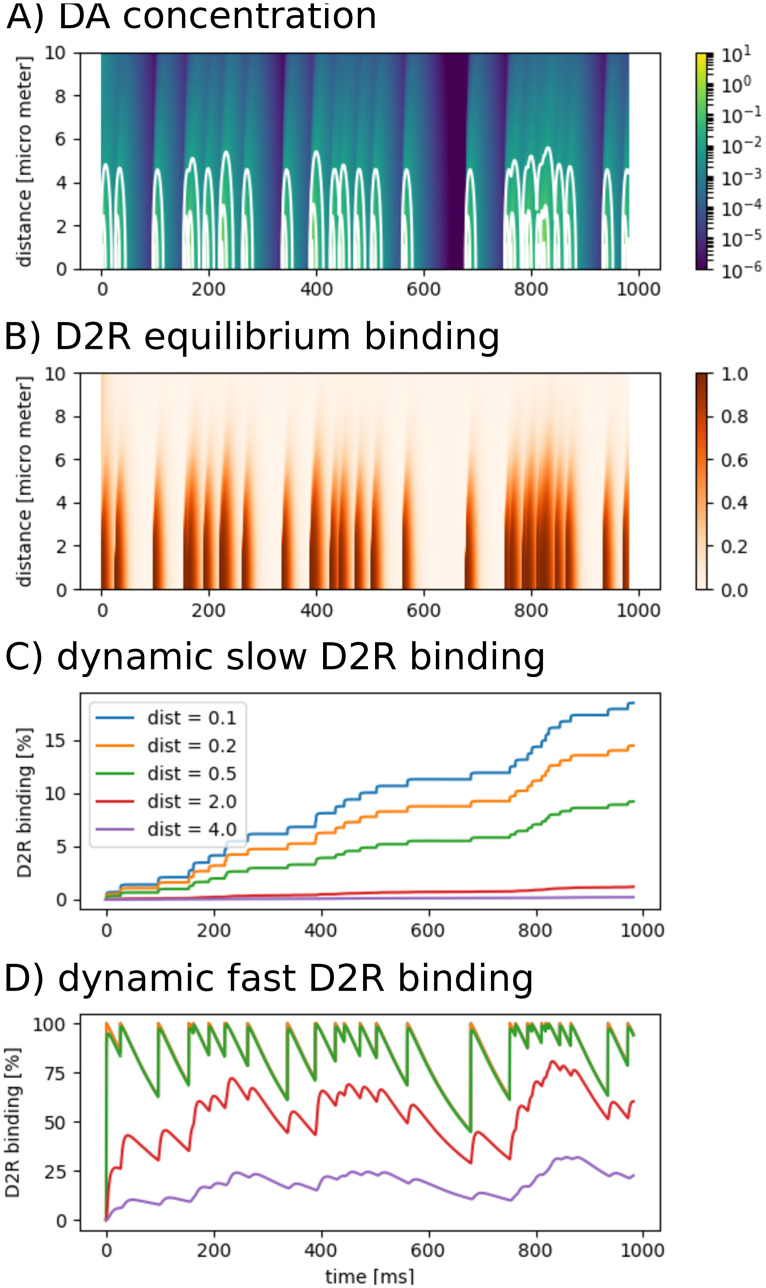
Multiple DA release events from synaptic terminal.A: Simulated concentration [μM] with 3000 molecules released per event. B: Associated equilibrium receptor binding (Michaelis-Menten kinetics). C: Associated slow receptor binding. Percentage of binding increases with each release event inside and close to release site. At 2μm distance from the synapse center increments become insignificantly small. D: Associated fast receptor binding. Again, at 2μm distance from the synapse center receptor binding becomes insignificantly low.